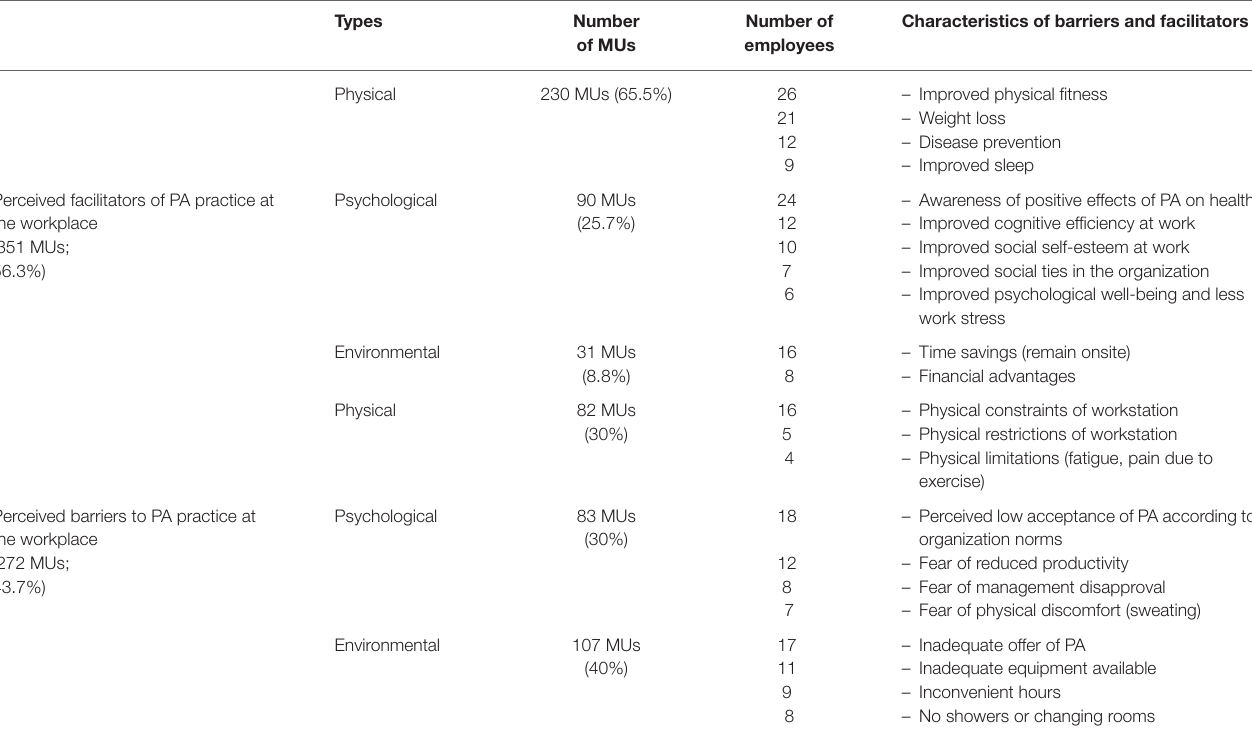
TABLE 2 | Perceived barriers to and facilitators of worksite PA practice at